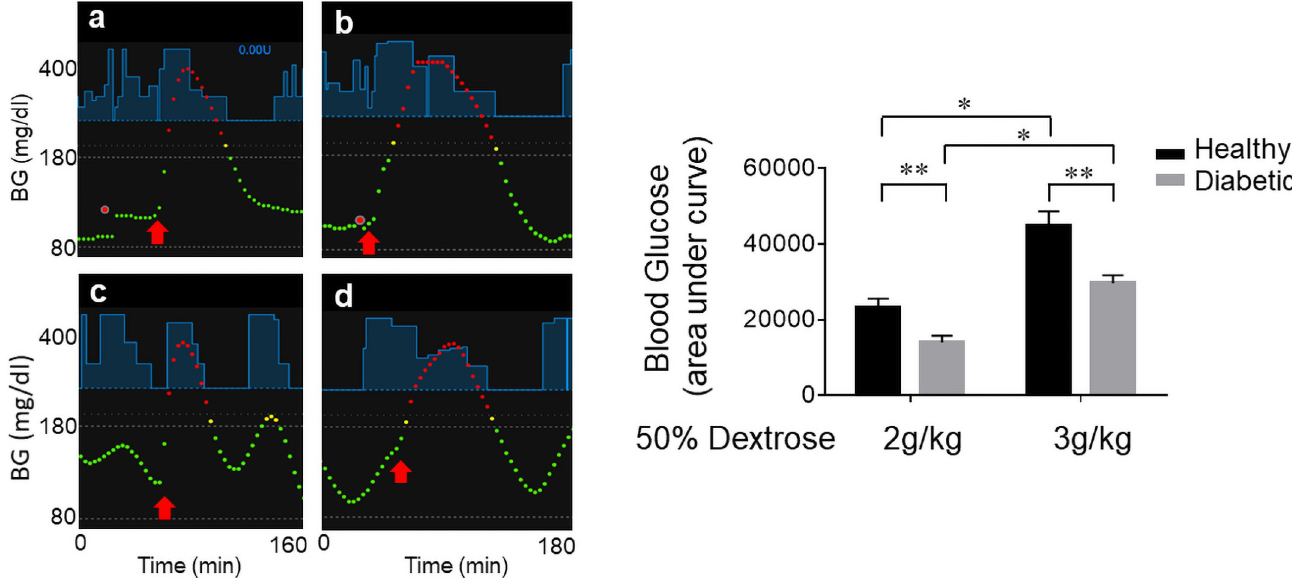
Fig 7. (A) BGL after intraperitoneal injection of 2 g/kg and 3 g/kg 50% dextrose in healthy and diabetic rats. Panels a and b show representative Nightscout images for BGL for healthy rats (n = 3) injected with 2 g/kg and 3 g/kg 50% dextrose, respectively, and Panels c and d show those for diabetic rats (n = 3). (B) Area under curve for BGL determined by Enlite sensor for each condition as indicated on the figure. Values are presented as means ± SEM (n = 3).